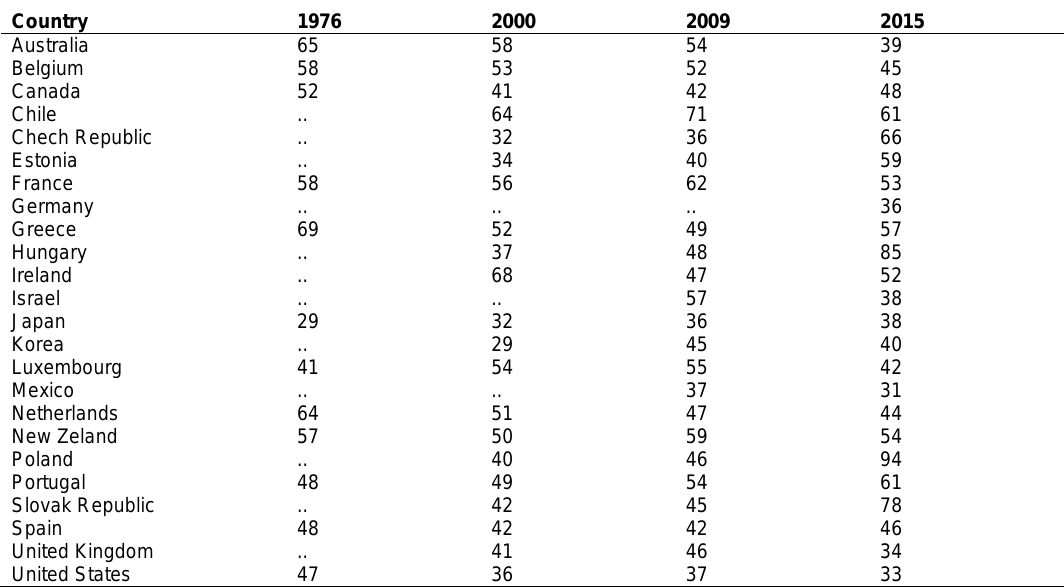
Table 1. Minimum wage as a proportion of the average wage (in%), 1976, 2000, 2009 and 2015 in OECD countries. Country